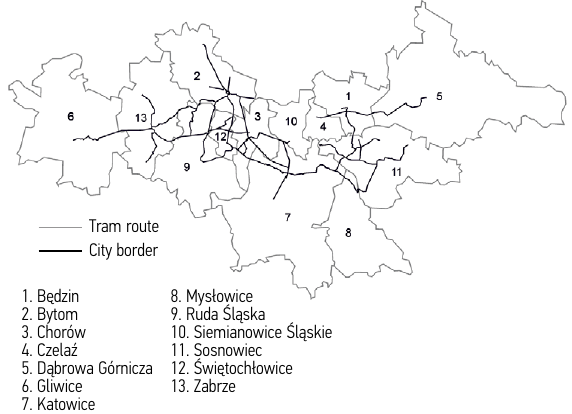
Fig. 1. Tramway network in Silesian